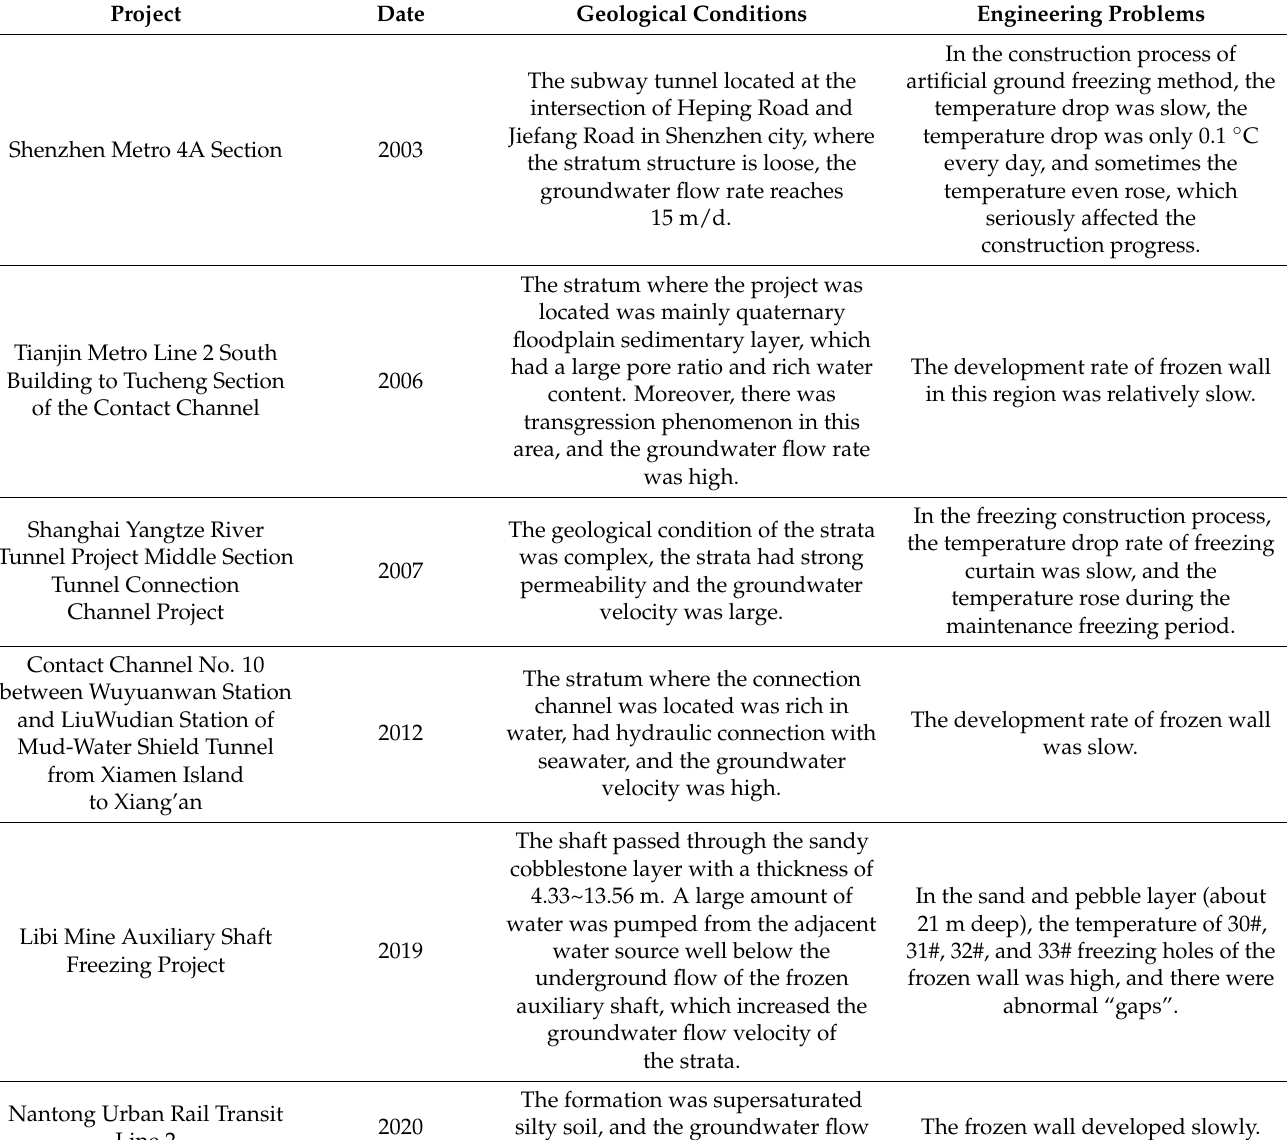
Table 1. Cases of freezing projects affected by